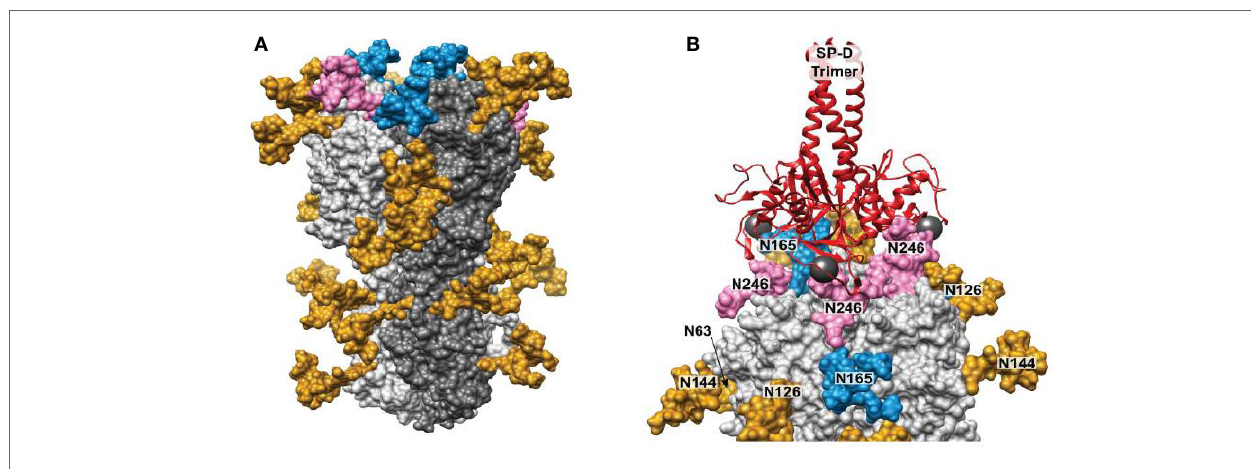
FiGURe 3 | Structure modeling of influenza A virus (IAV) hemagglutinin (HA) and molecular dynamics result showing binding of surfactant protein A (SP-D) neck and carbohydrate recognition domain trimer to the HA. (A) 3D model of glycosylated Phil82 hemagglutinin trimer (HA0). One HA monomer is shown in dark gray. Glycans at Asn165 and Asn246 are shown in blue and pink, respectively. (B) A model of trimeric SP-D (red ribbons) bound to three N-glycans on the H3 head domain (light gray surface). The 3D structure of the glycosylated H3 was taken from the MD simulation. In this snapshot, Man α residues at sites Asn 246, Asn 165, and Asn 246 on different protomers were approximately 45 Å apart, such that SP-D could bind each residue simultaneously. The calcium atoms found in each SP-D Man α binding site are shown (dark gray spheres) [this figure adapted from Khatri et al. (81) through free usage via Creative Commons CC-BY license].